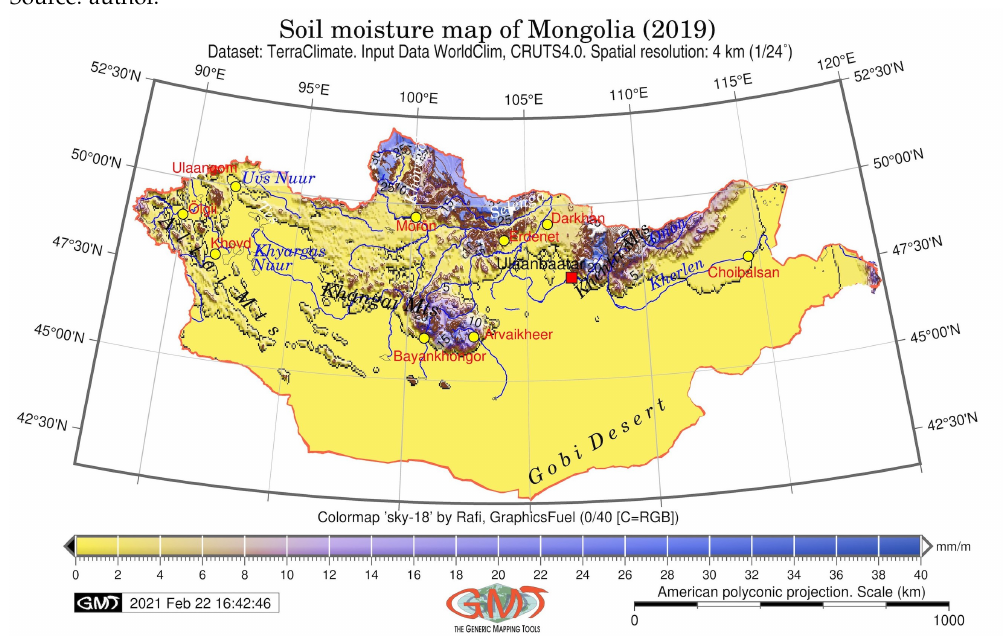
Figure 5. Soil moisture in Mongolia in 2019. Mapping: GMT by script available in Appendix B.4. Source: